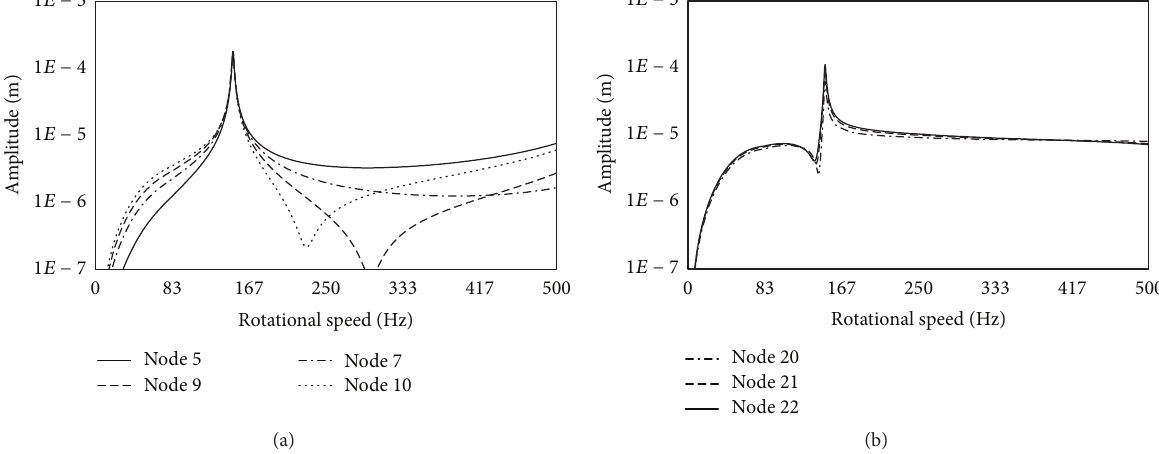
Figure 9: Unbalanced responses of the rotor-bearing system for the radial clearance of the squeeze film damper equal to 0.12 mm.